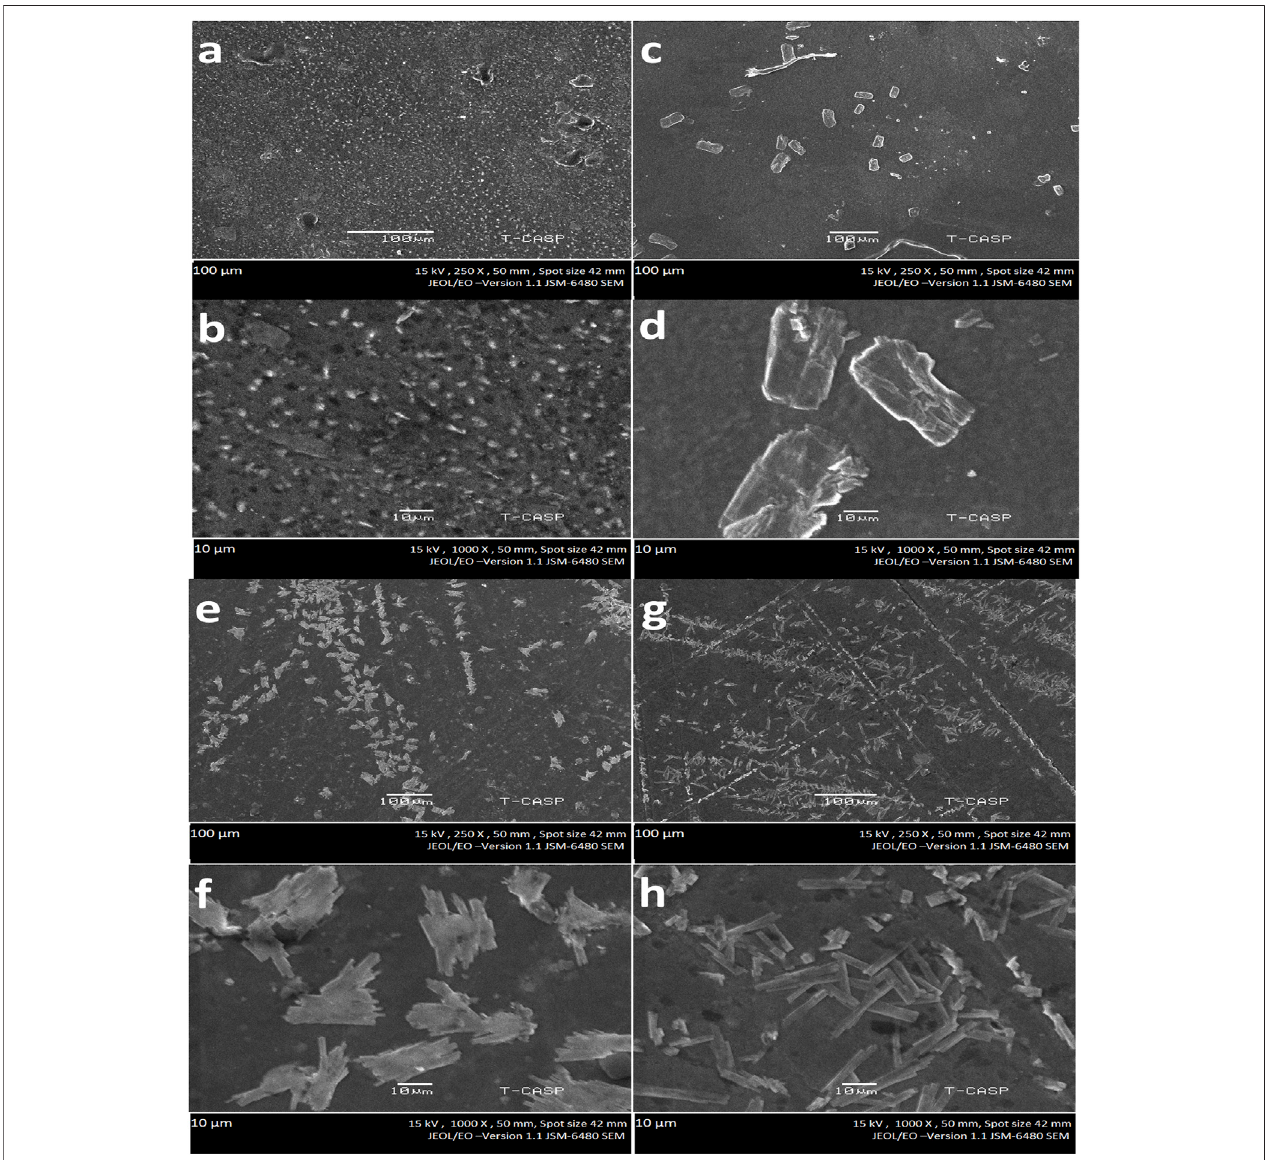
FIGURE 2 | Morphology of hydrogels at different magni fi cations (A,B) . PPC (Functionalized Sepiolite clay (cid:1) 0 wt%) (C,D) . PP1(Functionalized Sepiolite clay (cid:1) 0.05 wt%) (E,F) PP2 (Functionalized Sepiolite clay (cid:1) 0.1 wt%) (G,H) PP3 (Functionalized Sepiolite clay (cid:1) 0.15 wt%).